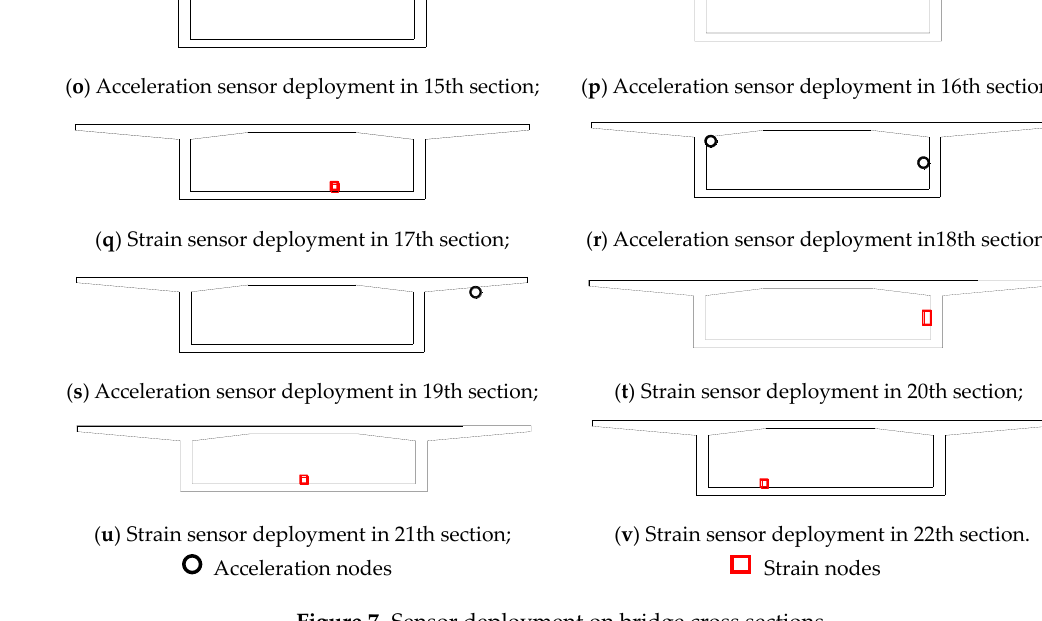
Figure 7. Sensor deployment on bridge cross sections.